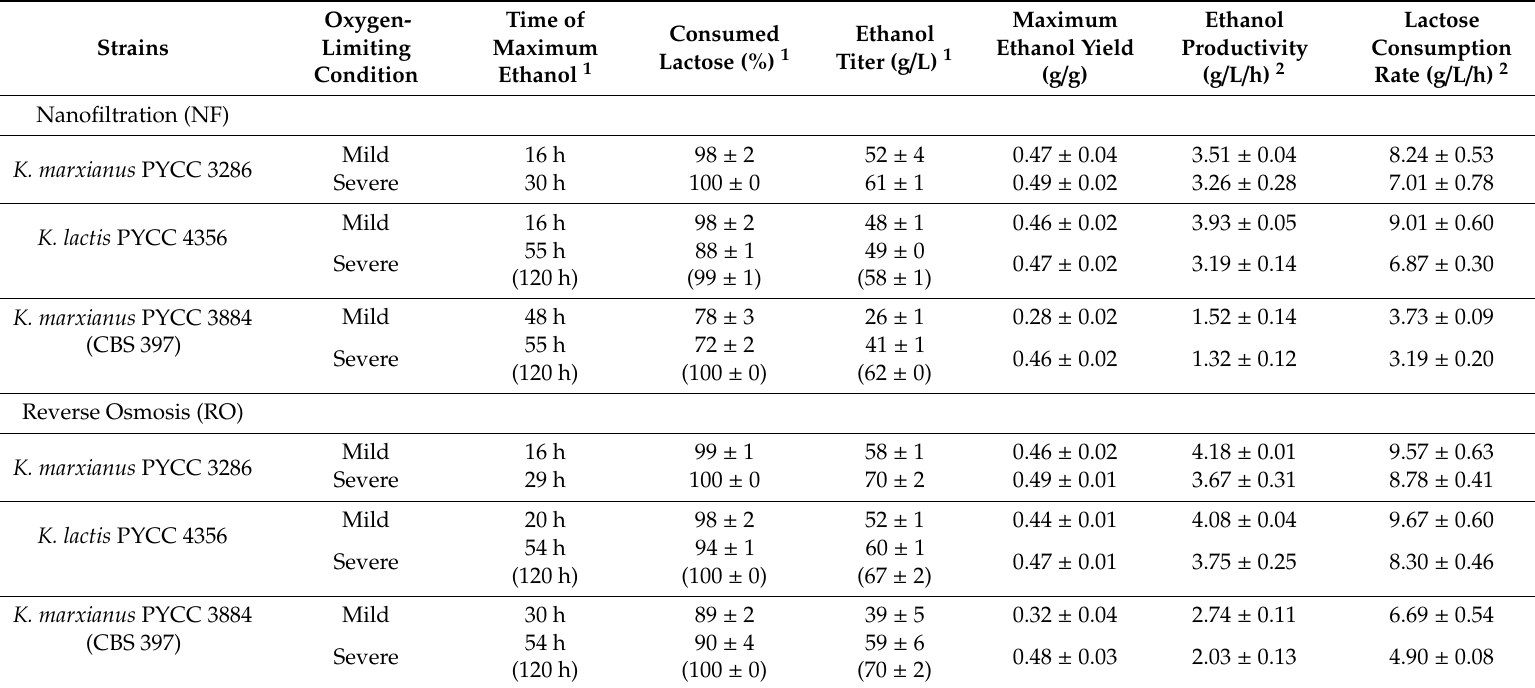
Table 5. Fermentation parameters under mild oxygen-limiting conditions versus severe oxygen-limiting conditions in the NF and RO retentates. Average values of three independent experiments with corresponding standard